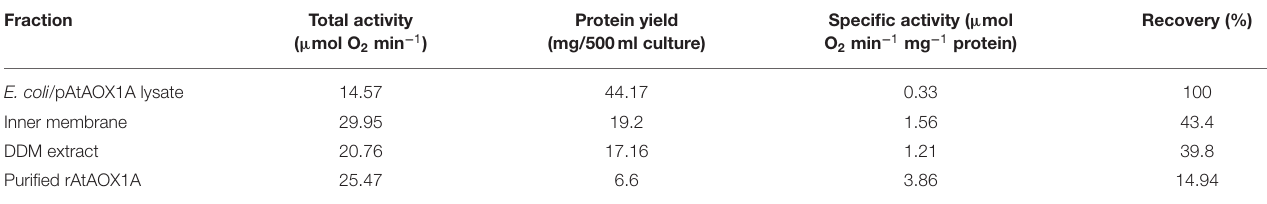
TABLE 1 | The membrane fractions of E. coli were prepared from 500ml of E. coli /pAtAOX1A culture and used for rAtAOX1A purification. Fraction